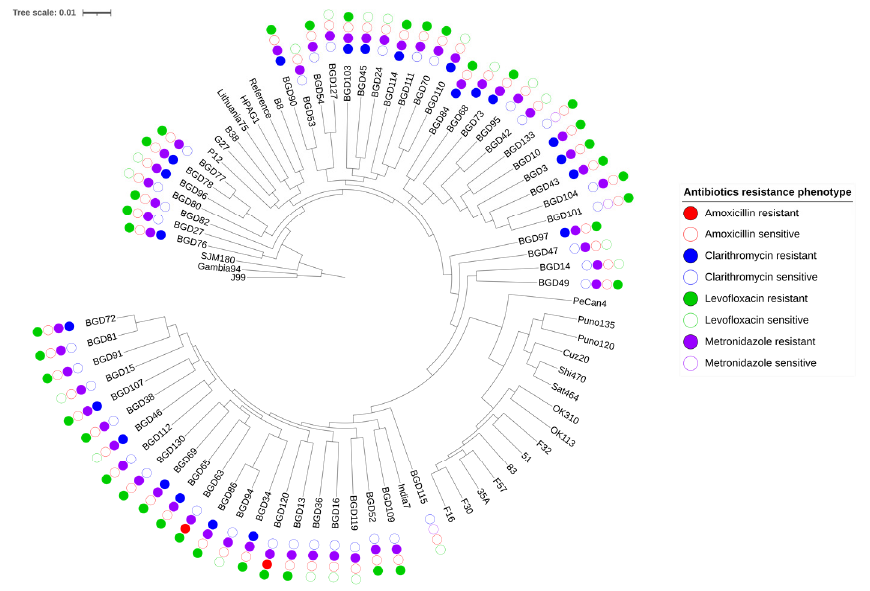
Figure 1. Phylogenetic tree of clinical H. pylori isolated from Bangladesh. Phylogenetic tree of Bangladesh clinical isolates was constructed based on the maximum likelihood method. The resistance phenotypes of antibiotics were also shown in filled color, as mentioned in the legend.